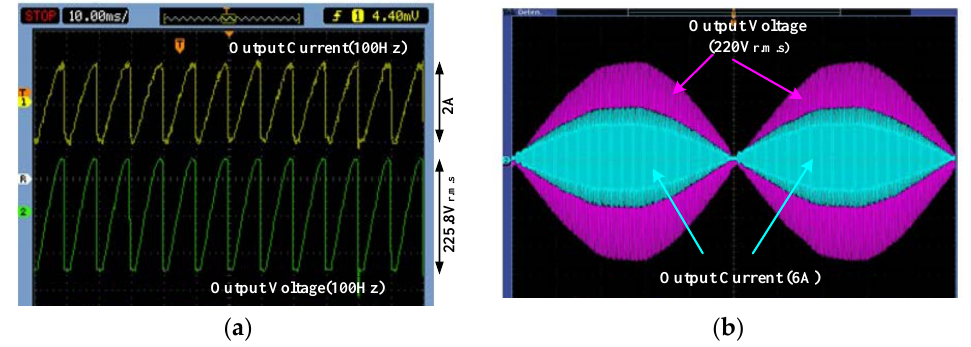
Figure 17. ( a ) Experimental verification of simulated output voltage and current at 100 Hz i.e., as a frequency changer. (Scale: output voltage, 75 V/div; output current, 1 A/div and time, 10 ms/div) and ( b ) experimental validation of output voltage and current of SPMC as a resonant converter for IH applications at 25 KHz. (Scale: Output voltage, 35 V/div; output current, 2 A/div).